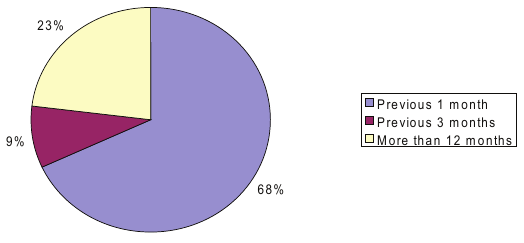
Figure 3 : Reported frequency of injuries sustained and the per- centages of the respondents. The majority (68%) of the welders sustained eye injuries in the previous one month.